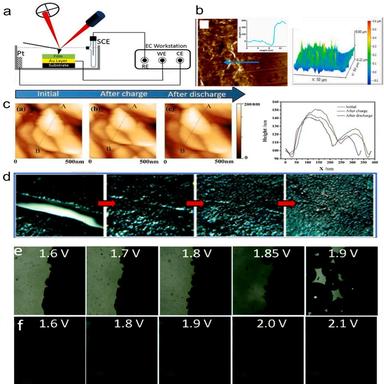
(a) Schematic of the homemade in situ EC-AFM measurement system. (b) AFM image of graphene-coated Al foil and the simulated image of AFM results . (c) AFM topographic image of the film electrode obtained in aqueous electrolyte at initial state, after charge process, after discharge process, and cross-section profiles of two selected grains. (d) Optical microscope images at different healing stages . In situ optical microscope images of the front surfaces of (e) the LMO/NTP full